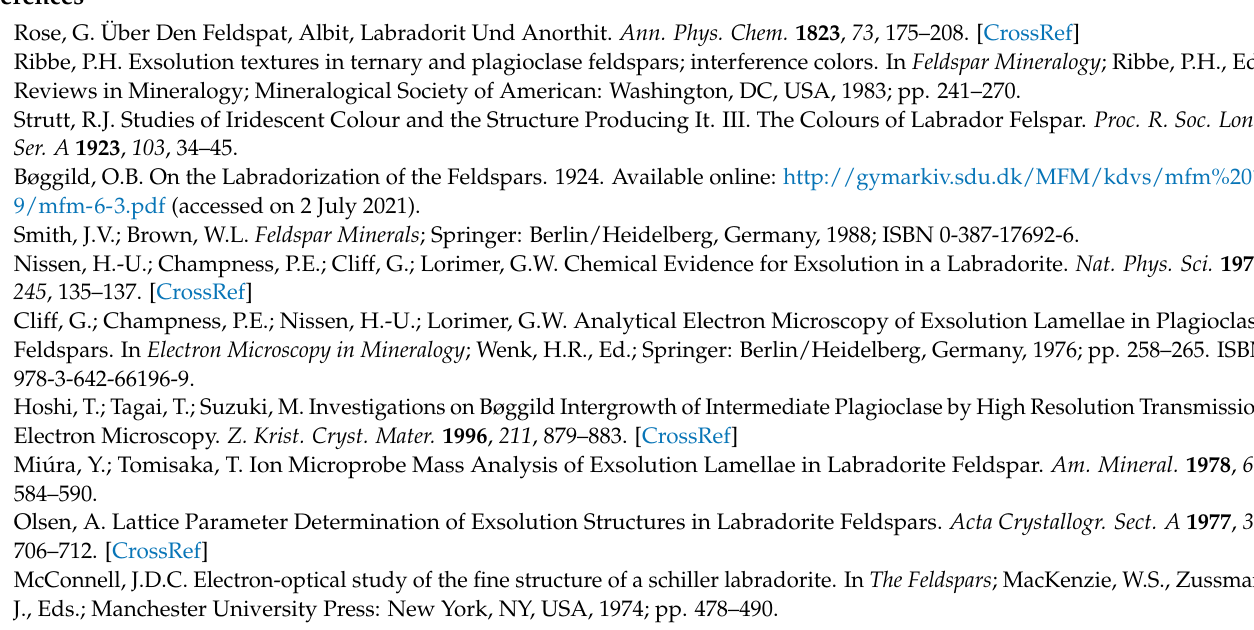
Figure S14: Single-crystal XRD frames from red-iridescent Gem118, Figure S15: Proposed phase diagram for plagioclase feldspars, Figure S16: Previously proposed phase diagrams for plagioclase feldspars, Table S1: EPMA analysis results of the samples studied, Table S2: Lamellar compositions from EDS spectra, Video S1: Rotation of the reconstructed 3D Ca and Na maps from the APT data. CIF: Average crystal structures refined from single-crystal XRD